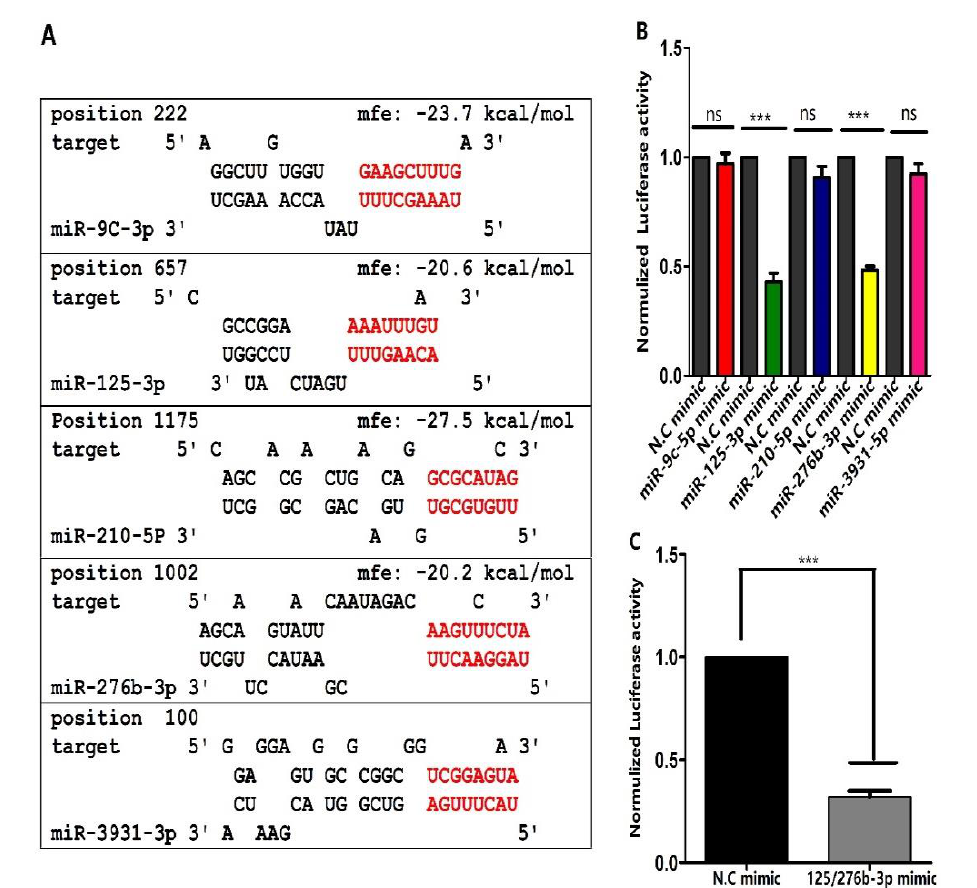
Figure 1. miRNAs targeting orb2 as predicted by RNAhybrid and confirmation through dual luciferase reporter assay. ( A ) Potential miRNA target sites of miR-9c-3p, miR-125-3p, miR-210-5p, miR-276b-3p, and miR-3931-3p. Seed sequence of the miRNAs and their putative binding sites in the 3′UTR are indicated by red letters. mfe: indicate match free energy value. ( B ) Effects of miR-9c-3p, miR-125-3p, miR-210-5p, miR-276b-3p, and miR-3931-3p on luciferase activity. ( C ) The effects of combination of miR-125-3p/276b-3p on luciferase activity. Treatments were compared with their respective controls using ANOVA (Tukey-test, p < 0.05). *** indicates p < 0.001 and ns non-significant respectively.